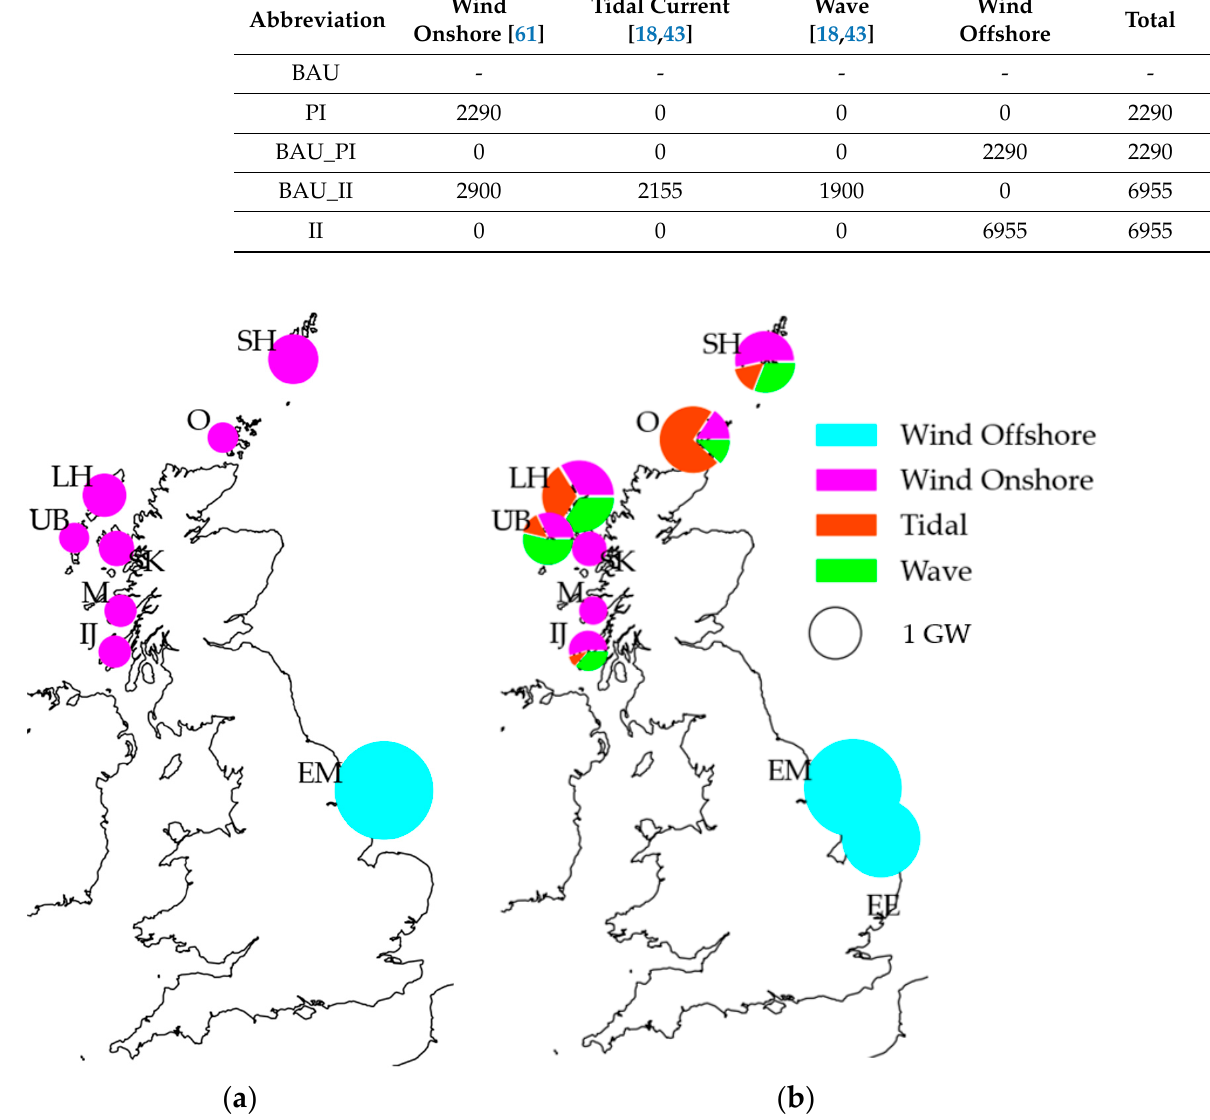
Figure 2. Modelled capacity for each scenario group: ( a ) Planned Interconnections (PI) and ( b ) Improved Interconnections (II). Island capacity is shown for onshore wind (pink), tidal (orange) and wave (green), which will be compared with identical offshore wind (blue). Island/modelled node names abbreviated here are given in Table 3. Capacity installed (MW) additional to the BAU scenario.